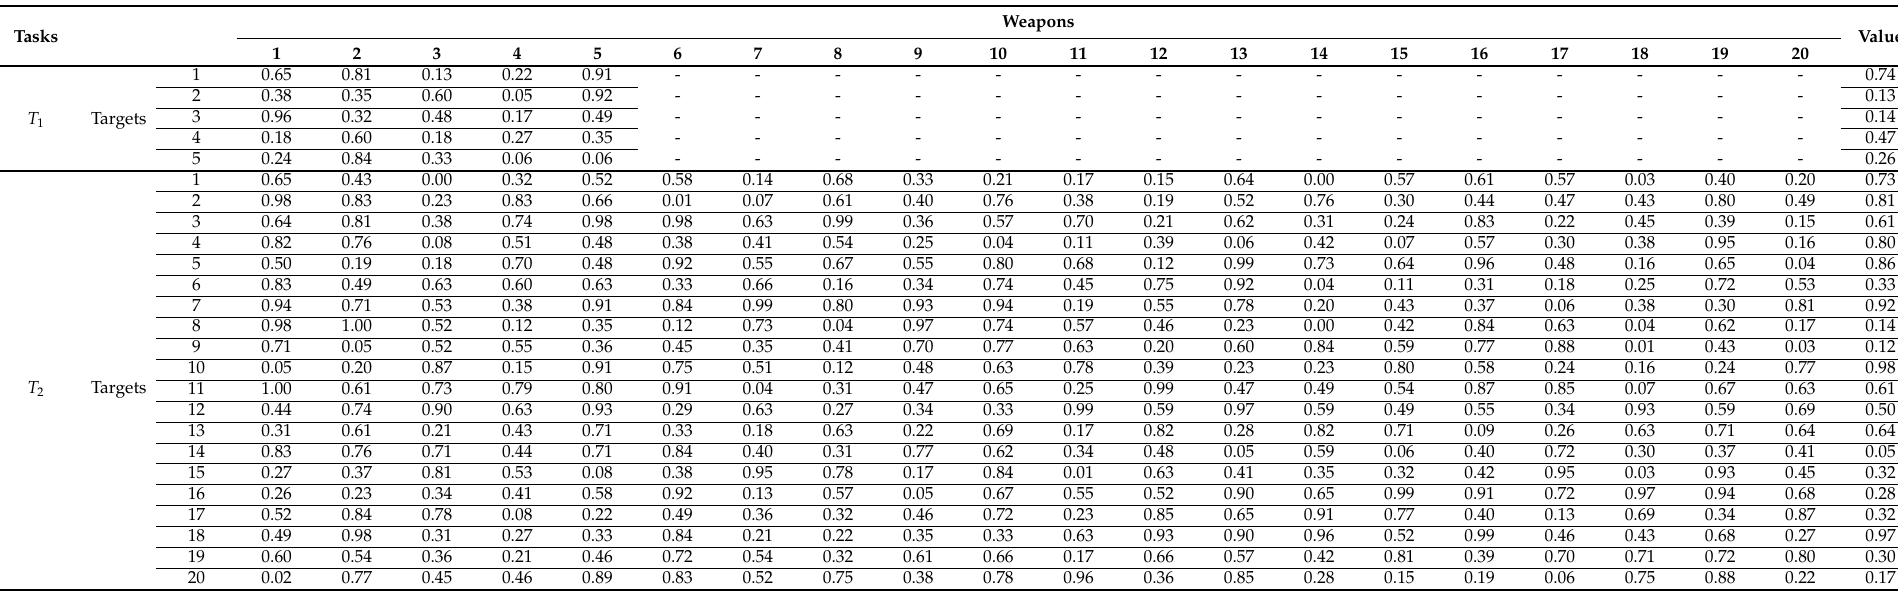
Table A5. Details of the destructive value of every target and the probability of kill for every weapon in the two component tasks of problem 5 in Table 2. Each task is a WTA problem. Tasks